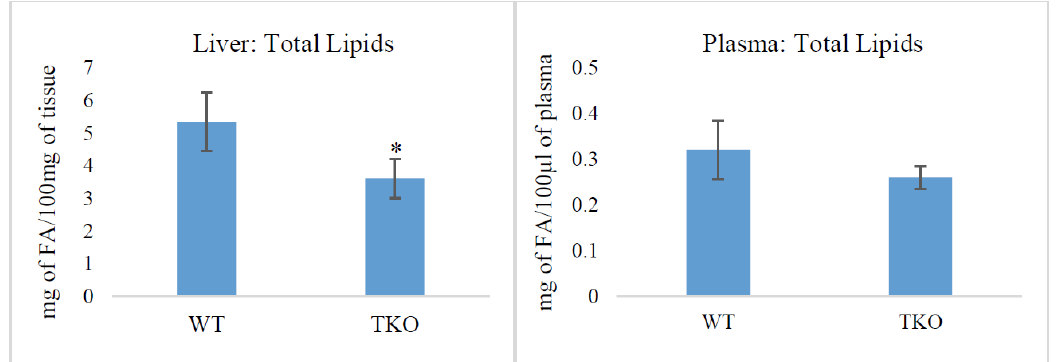
Figure 1. Total lipid content in liver (mg of fatty acids in 100 mg of tissue) and plasma (mg of fatty acids in 100 µL of plasma) from wild-type (WT) and triple-synuclein null mutant (TKO) mice. Means ± s.d. ( n = 6) are shown. * p < 0.05.